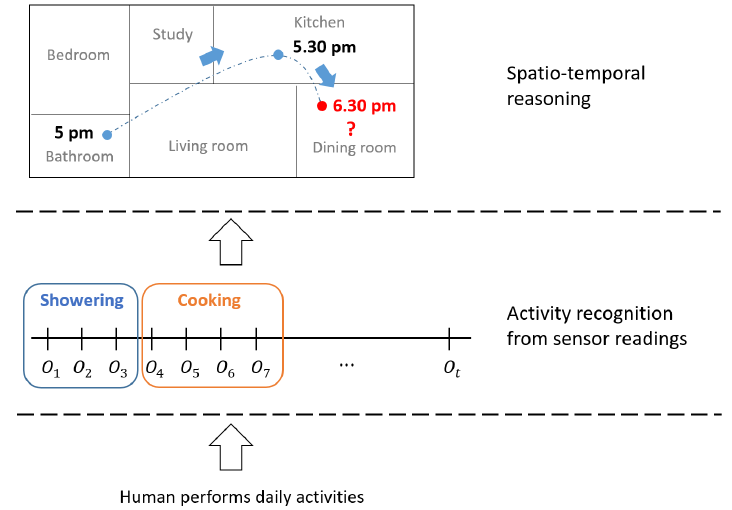
Figure 1. Spatio-temporal reasoning in smart homes: ( Bottom ) User in a smart home performs their daily activities. ( Middle ) Sensor readings are mapped to user activities. ( Top ) Using location and time information for